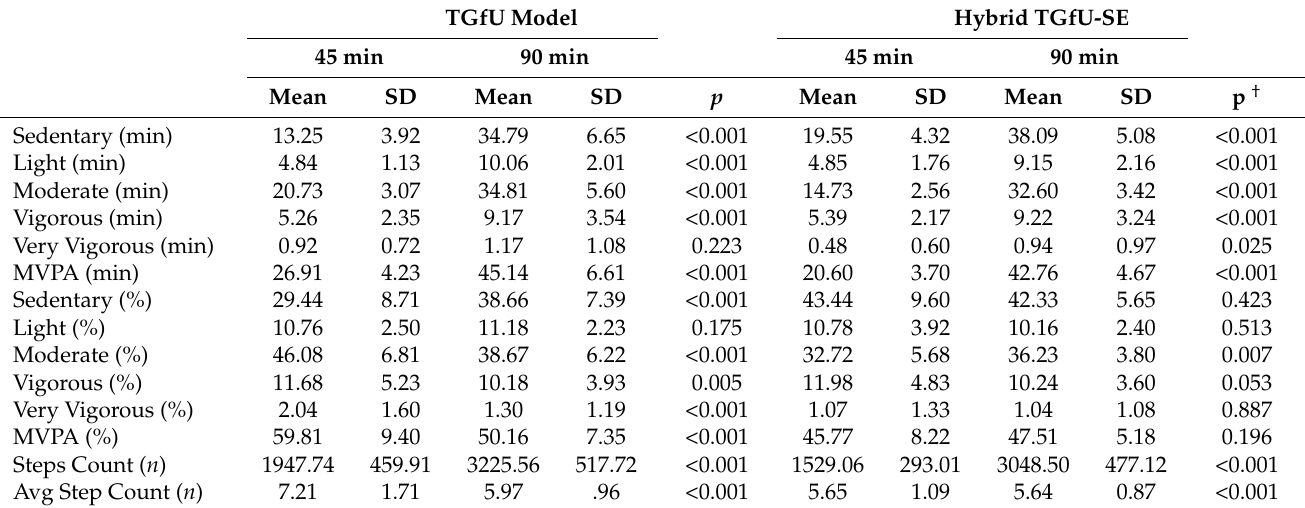
Table 2. PA intensities, the number of total steps (n), and the average step count per minute for 45 min and 90 min classes following different pedagogical models (TGfU and hybrid TGfU-SE).